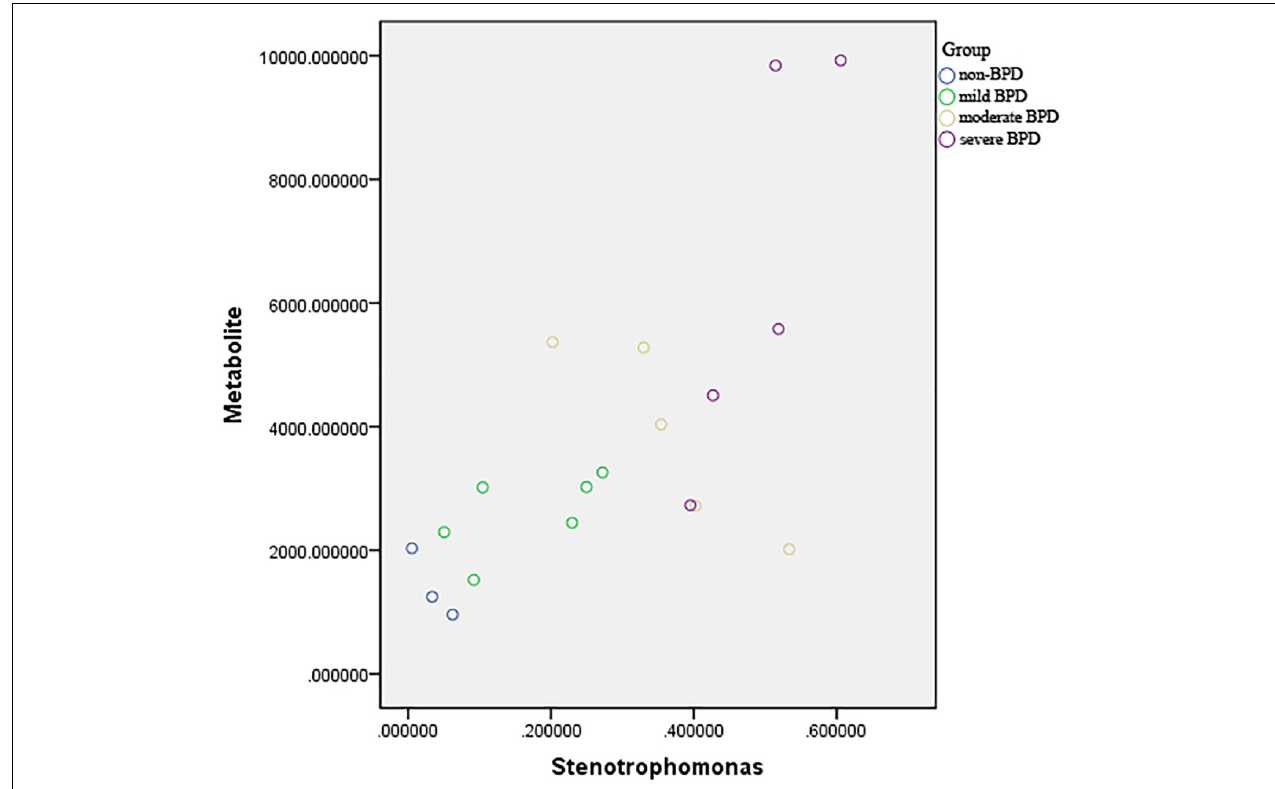
FIGURE 5 | Scatter plot of the association between abundance of Stenotrophomonas and sn-glycerol 3-phosphoethanolamine level. r = 0.629, P = 0.007 (sever BPD group: n = 5; moderate BPD group: n = 5; mild BPD group: n = 6; non-BPD group: n = 3).